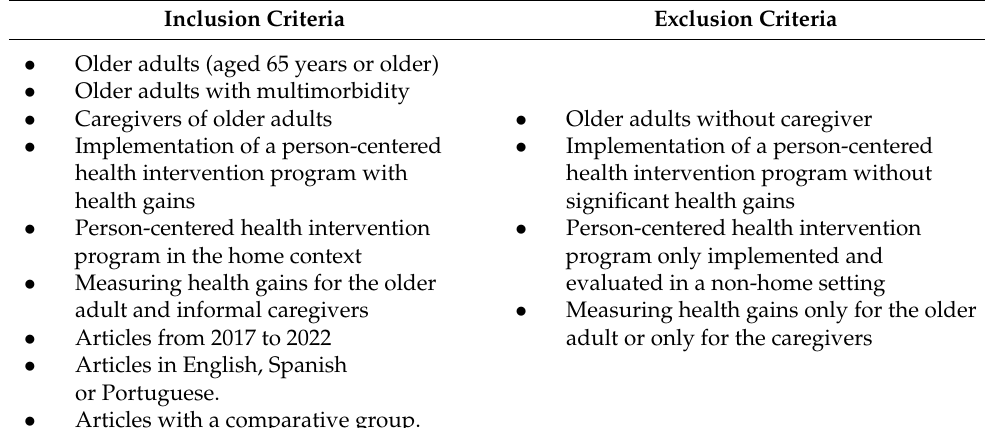
Table 1. Summary of inclusion and exclusion criteria. Inclusion